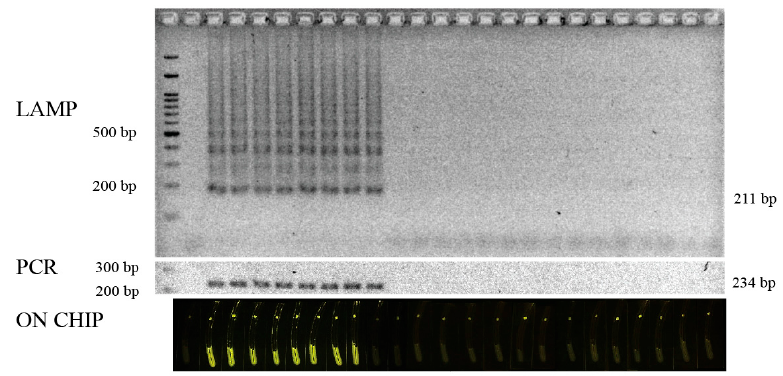
Figure 3. The specificity of the LAMP reaction for Listeria monocytogenes compared with that of the PCR and detection on the chip; Lane 1, 100 base pair ladder; Lane 2, non-template control; Lane 3, L. monocytogenes plasmid; Lanes 4–10, seven strains of L. monocytogenes DNA; Lanes 11–14, four strains of L. innocua ; Lanes 15–16, two strains of L. ivanovii ; and Lanes 17–25, DNA from L. welshimeri , Vibrio cholera , V. parahaemolyticus , Salmonella enteritidis , Escherichia coli O157:H7, E. coli ETEC, E. coli EPEC, Pseudomonas putida , and Shigella flexneri .